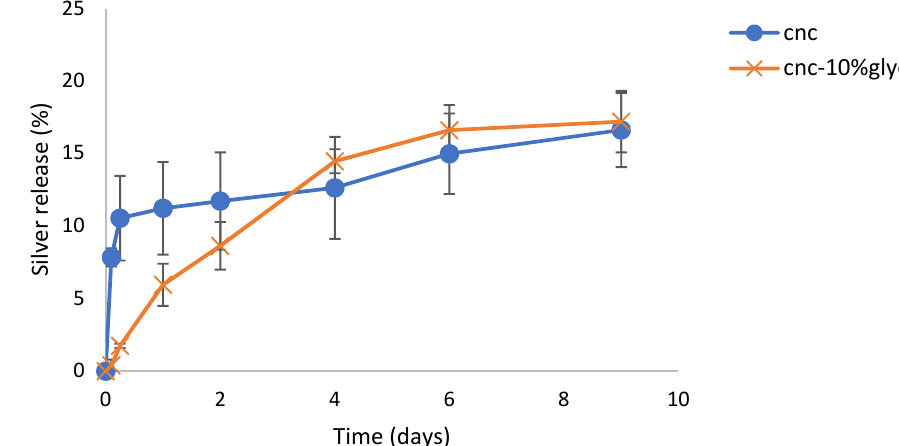
Figure 8. Time course of the release of silver from SDF loaded CNC hydrogels films in water.